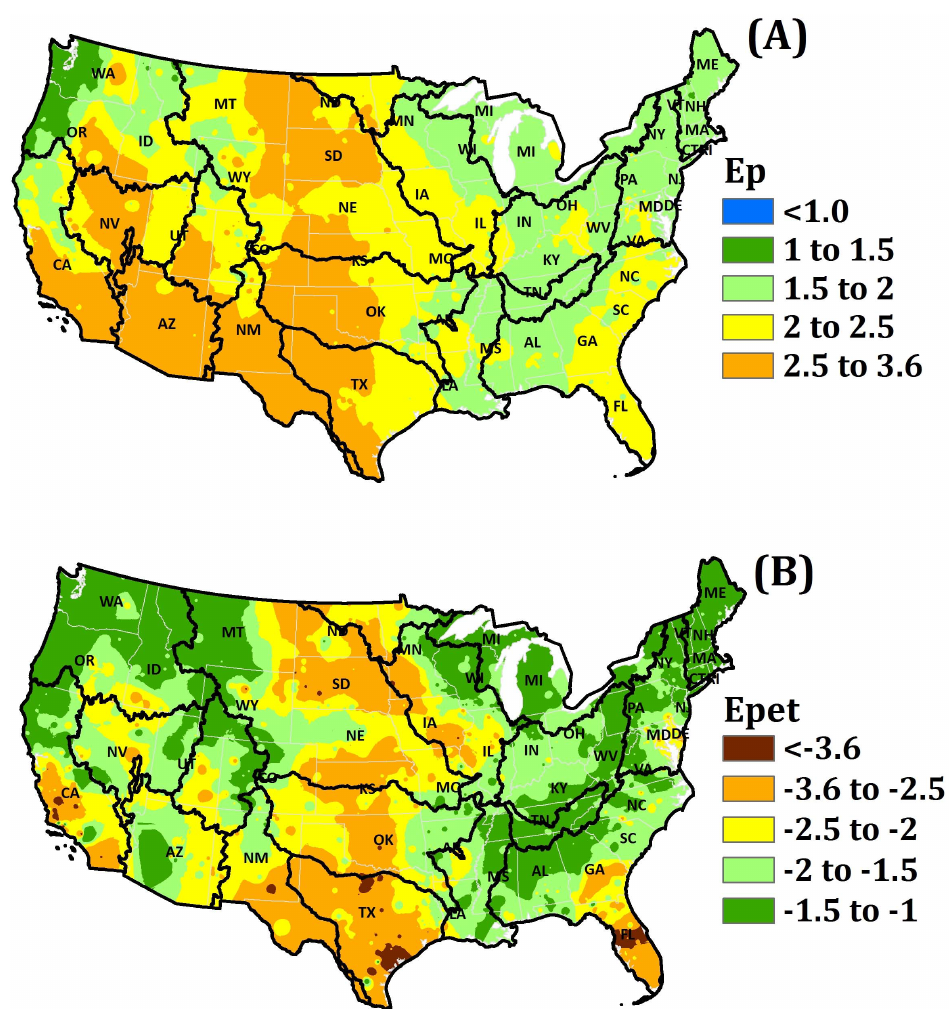
Figure 2. Hydro-climatology of the conterminous US; (A) Precipitation elasticity of streamflow ( e p ) and (B) Evapotranspiration elasticity of streamflow ( e pet ).